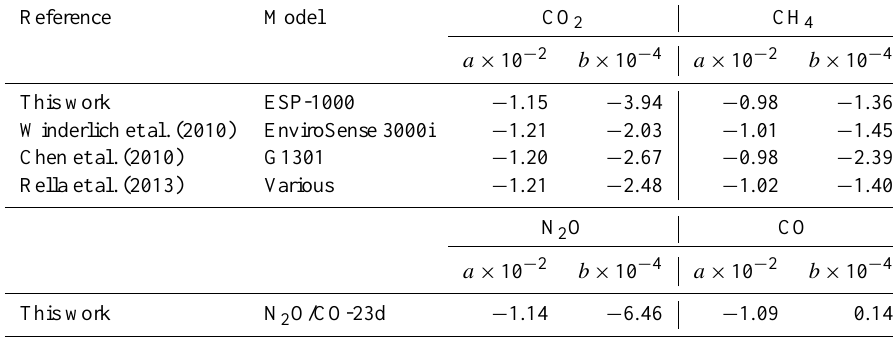
Table 3. Comparison of water correction function fit parameters (Eq. 6), with water vapor in percent. Reference